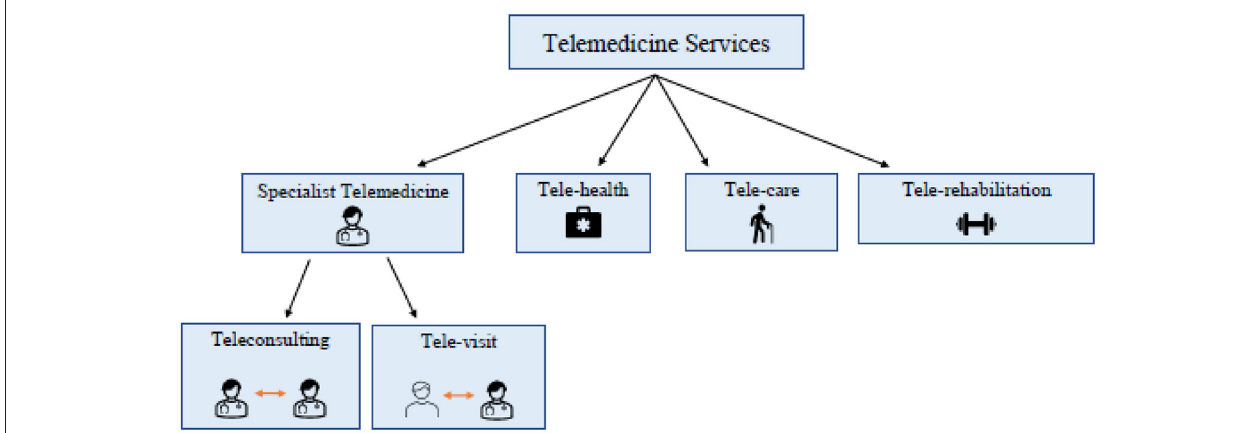
FIGURE 1 | Schematic representation of the different telemedicine components.